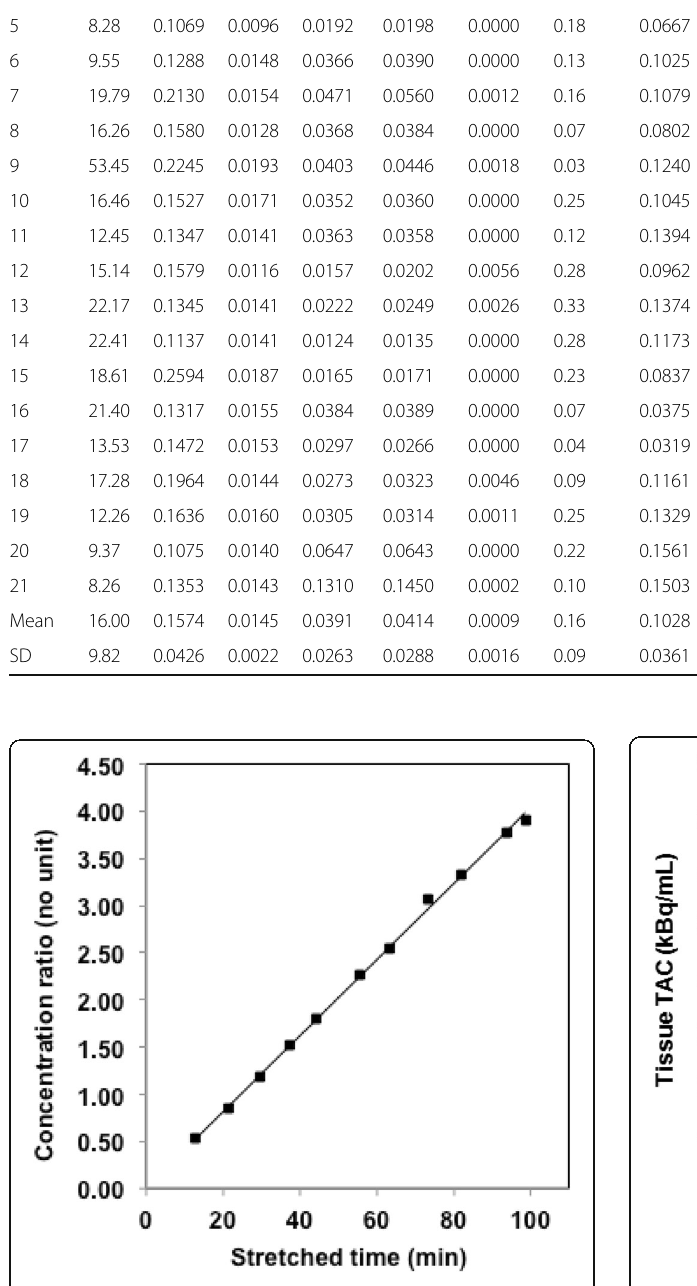
Fig. 3 Typical 3P-KMA fitting of 18 F-FDG tissue TAC (patient 9 in Table 1; R = 0.998; P < 0.001). PET data (square) are uncorrected for 18 F physical